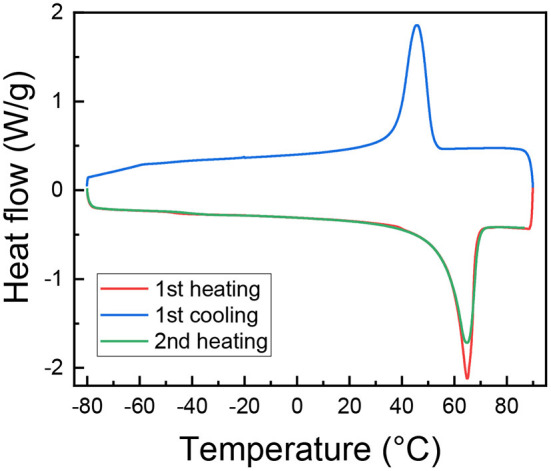
DSC thermogram of (PEO)16LiTf.